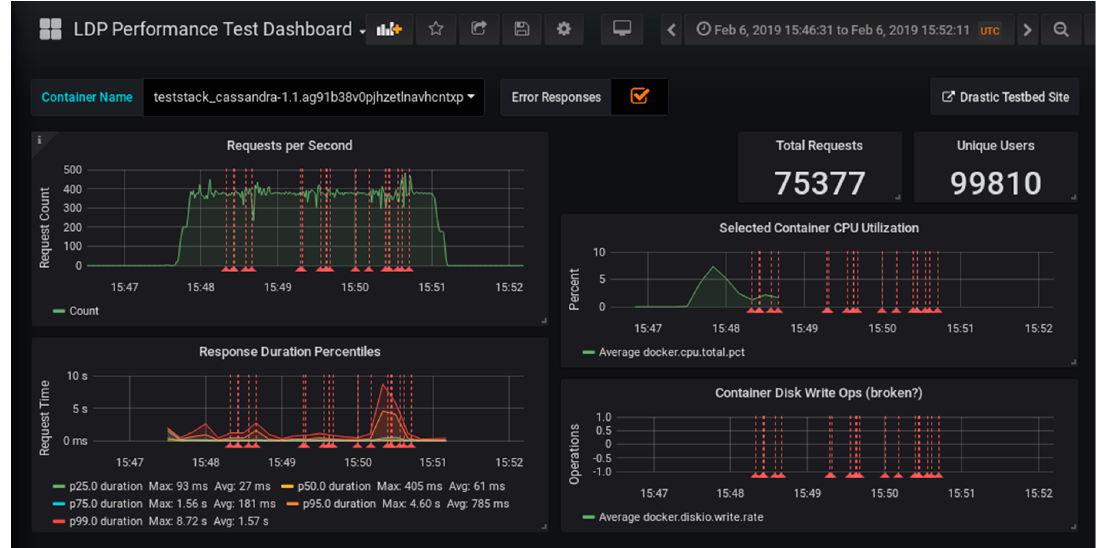
Figure 1. Dashboard display of a typical test run.